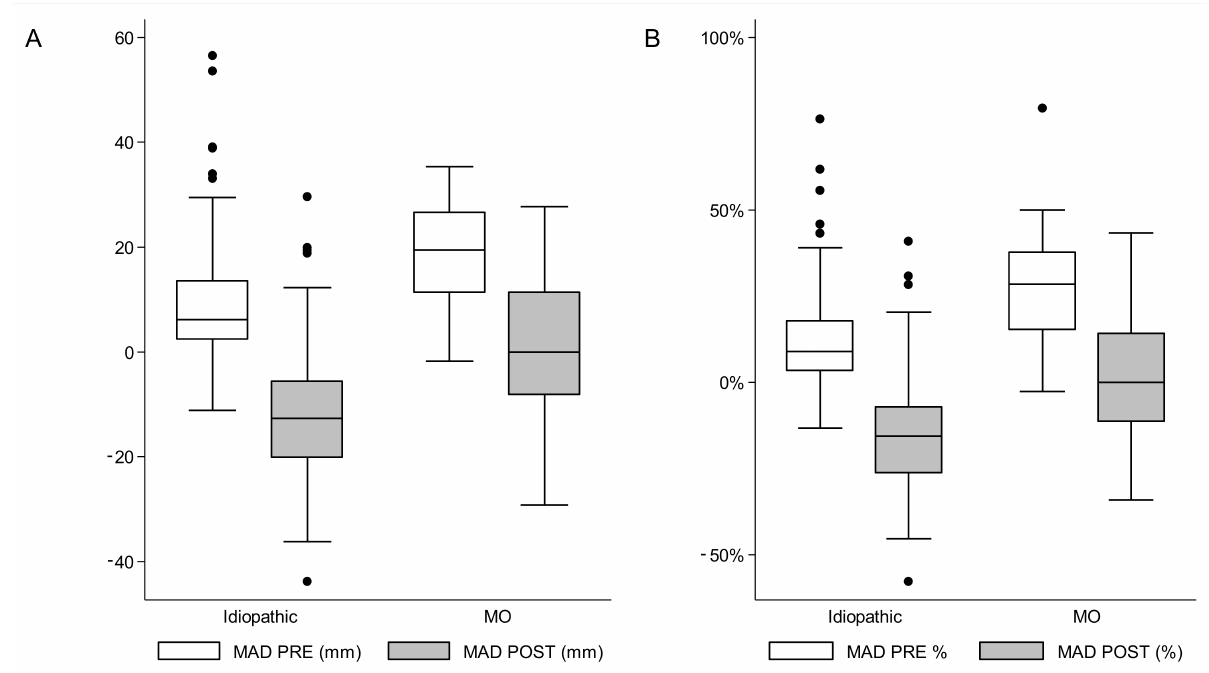
Figure 3. Box plots illustrating preoperative and postoperative mechanical axis deviations (MADs) in MO and idiopathic groups, expressed as absolute and relative deviation. ( A ) MADs expressed as an absolute value. ( B ) MADs expressed as a relative deviation. The black dots indicate the outliers, i.e., observations with values not included within 1.5 × IQR (interquartile range) from upper and lower